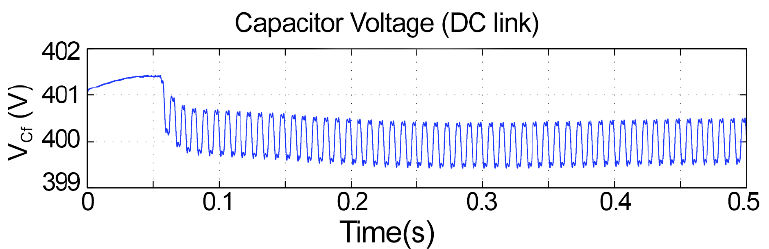
Figure 18. Capacitor voltage with a fuzzy controller.